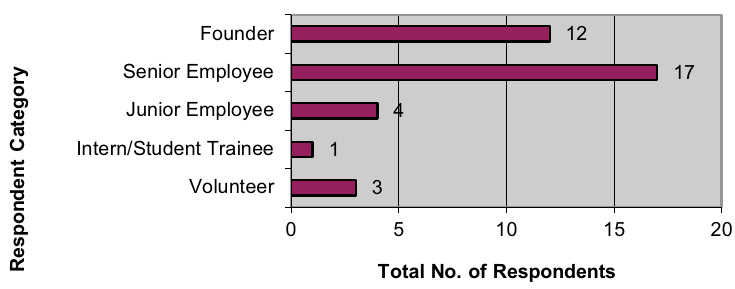
Figure 1. Reported positions held by reintroduction survey